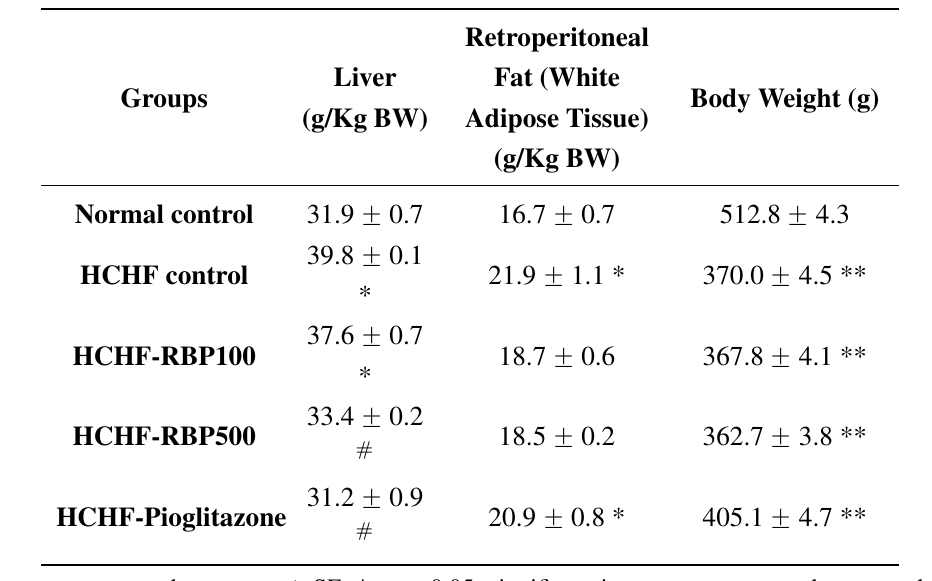
Table 3. The effect of RBP on body weights and relative weights of livers and white adipose tissues in HCHF-fed